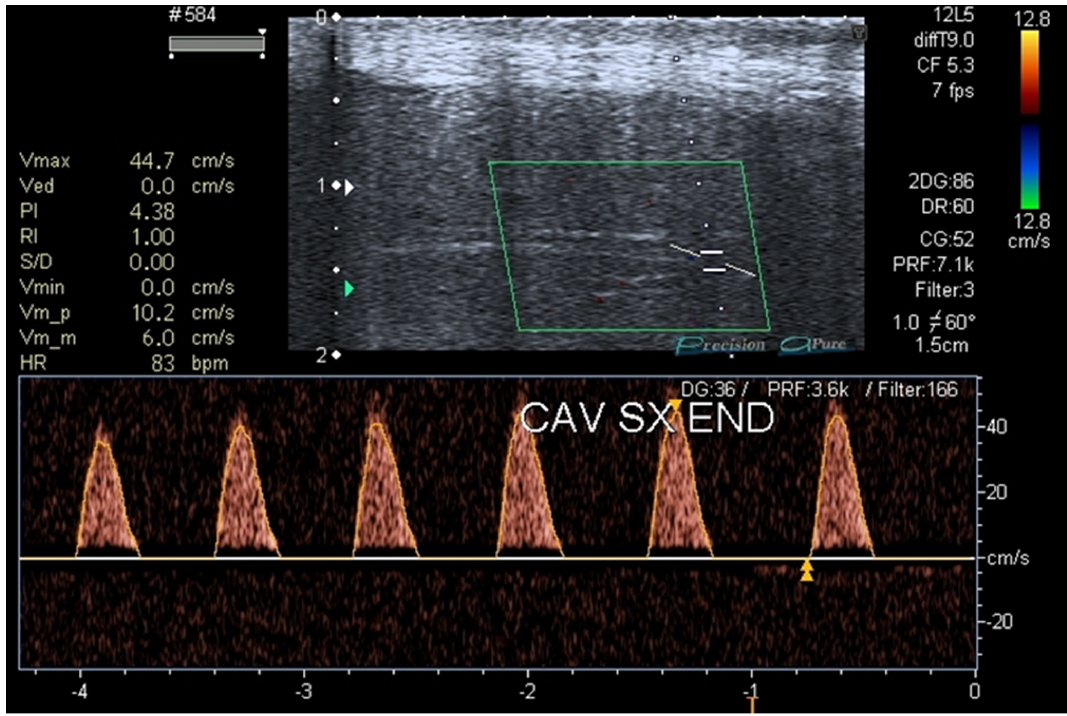
Figure 3. Penile duplex ultrasound at T3 (18 months after patient’s first visit).